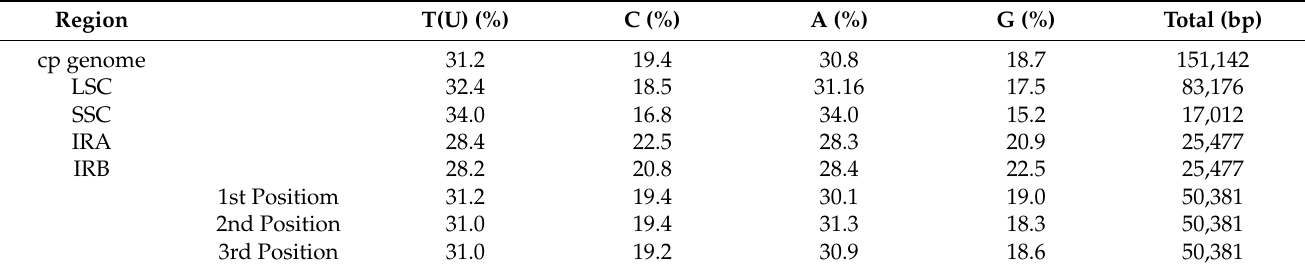
Table 1. Nucleotide composition in the H. forskaolii cp